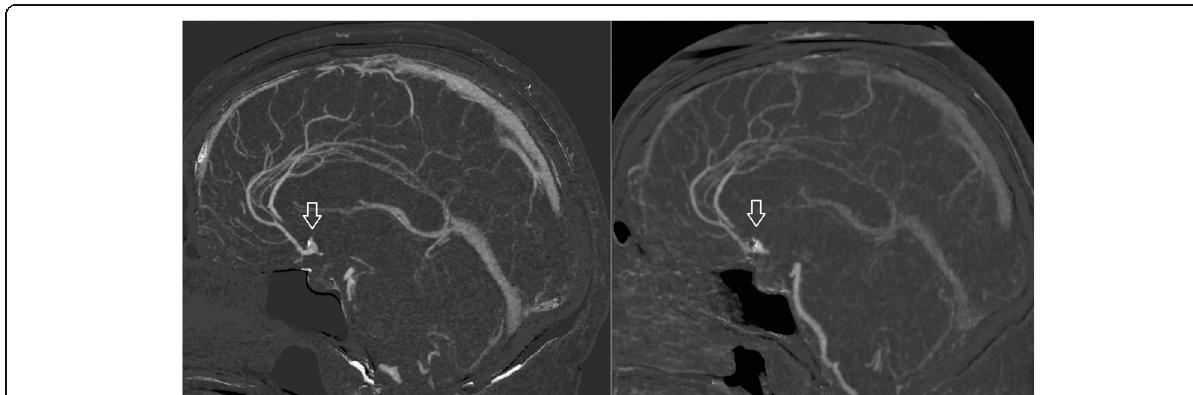
Fig. 2 Sixty-nine-year-old female with surgical clip-treated anterior communicating aneurysm. Follow-up with subtraction CTA demonstrates a remnant of the aneurysm (arrows). Image quality of subtraction CTA is superior on the UHR system (left image) as compared to subtraction CTA on a conventional CT system (right image) due to increased spatial resolution (0.25 × 0.25 mm versus 0.5 × 0.5 mm)